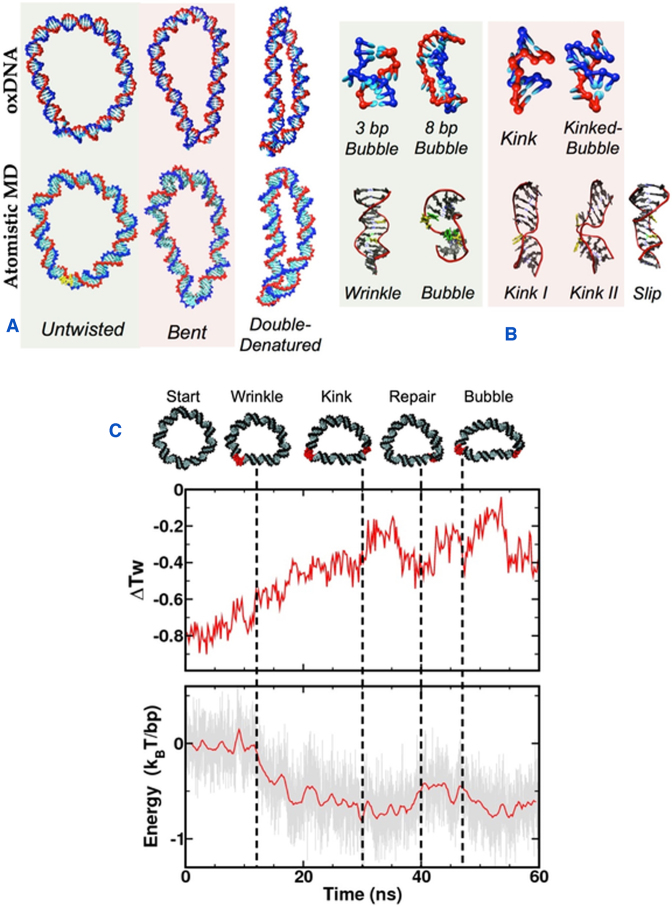
(A) Representative global conformations of DNA minicircles containing defects observed at ΔLk ≈ −1 in oxDNA (top) and atomistic MD (bottom). (B) Detailed structures of the defects observed in the oxDNA and atomistic MD simulations (where yellow indicates a denatured site). (C) An example of the choreography of cooperative denaturation observed in a ΔLk ≈ −1 RANDOM minicircle in a representative atomistic MD simulation: (top) Snapshots of the disrupted minicircles showing the time dependent structural changes (middle) Time evolution of the average twist deviation showing the relaxation of the superhelical stress due to these structural disruptions (bottom) Time evolution of the reduction in the stress energy relative to the starting structure (which is arbitrarily set to be zero) during this atomistic MD simulation. Dashed lines indicate which DNA structures emerge as a result of the twist and energetic relaxation during the atomistic MD trajectory.